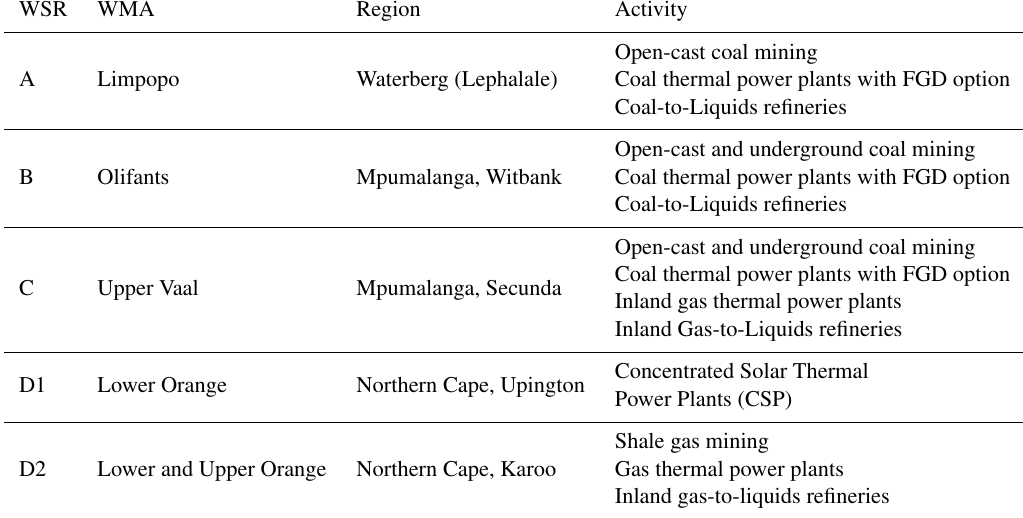
Table 1. Regional variability in potential power generation activities in each water supply region and associated